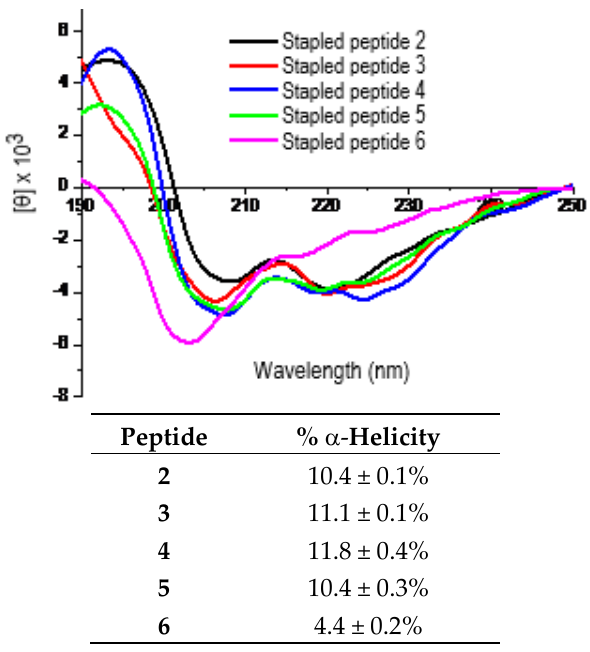
Figure 2. Representative CD spectra of the stapled peptides 2 – 6 (each at 25 µ M in ddH 2 O, 25 ◦ C) and the calculated % α -helicity values. Each peptide was assayed in duplicate at 25 µ M and / or 50 µ M in ddH 2 O. The mean residue ellipticity ([ θ ]) and the % α -helicity values were calculated according to the literature equations [19]. Note: The % α -helicity values (mean ± standard deviation) were calculated for peptides 2 – 6 from the [ θ ] values at 222 nm (i.e., [ θ ] 222 ) and the maximum [ θ ] 222 . See Experimental Section for experimental details.